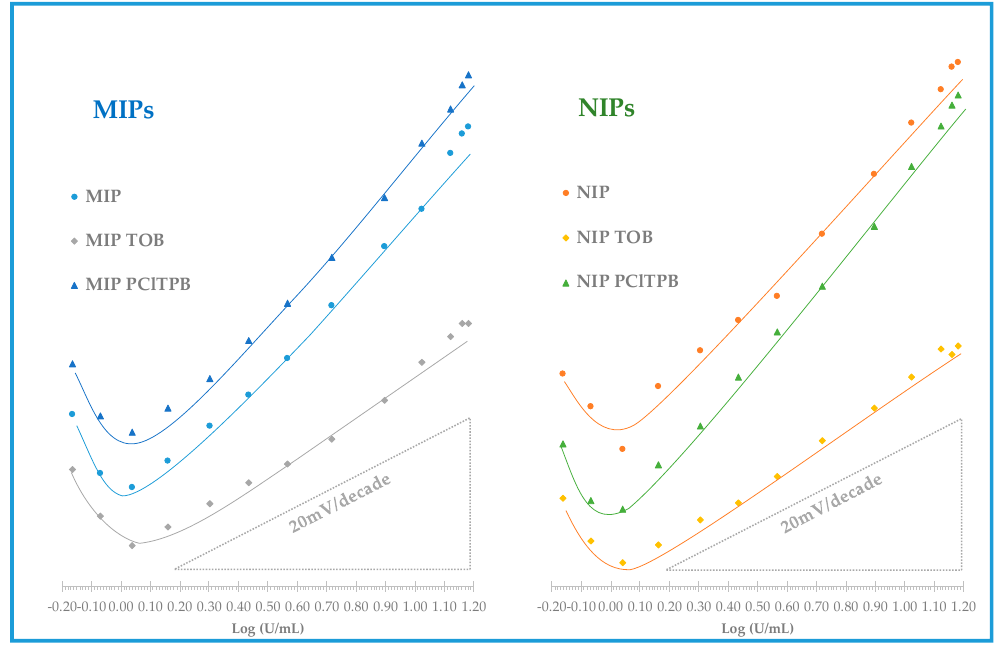
Figure 6. Potentiometric response of CA15-3 PVC membrane sensors with CA 15-3 standard solutions prepared in HEPES buffer, in pH 6.5, in the presence of a constant concentration of CEA.